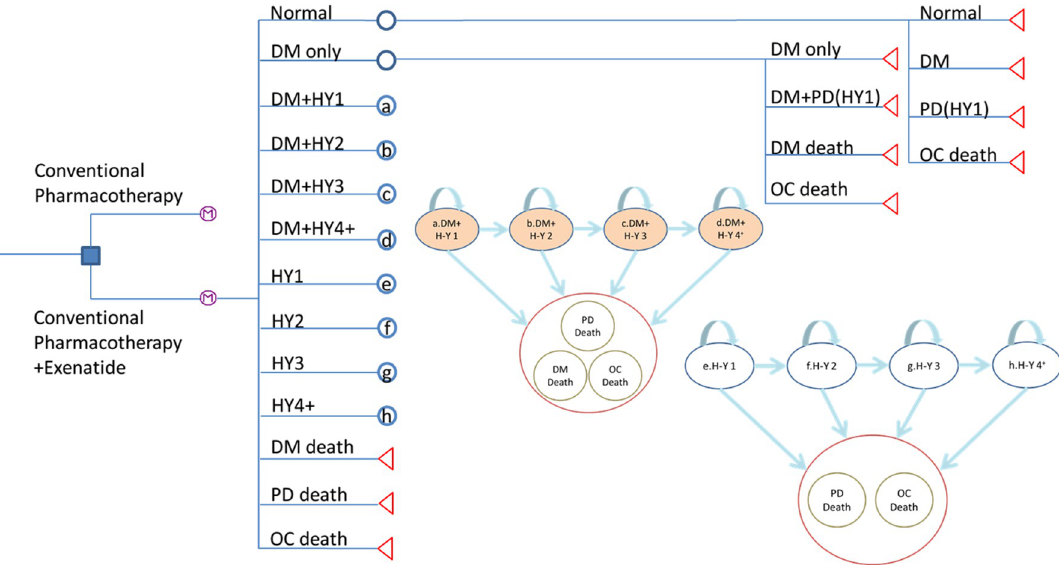
Fig 1. The Markov model for cost-effectiveness analysis for the add-on exenatide effect on PD with DM.